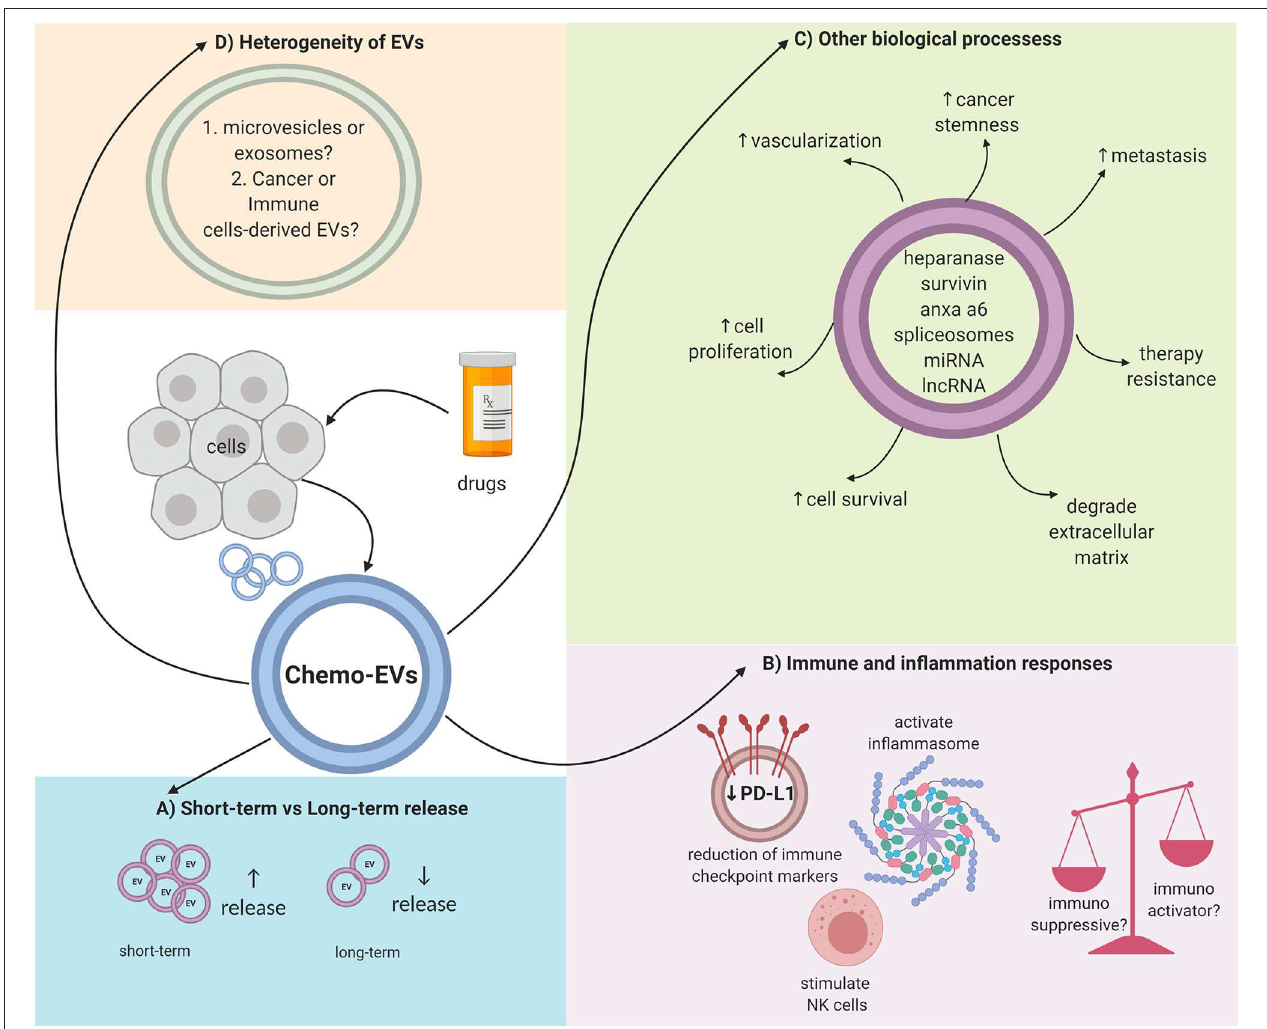
FIGURE 1 | Overall schematic representation on the complex properties of chemo-EVs. (A) The number of released EVs could be dependent on the duration of drug stimulation. (B) Immunomodulating effects of chemo-EVs (e.g., reduced immune checkpoint markers such as PDL-1, activated inflammasome, and stimulate natural killer cells). Nevertheless, the uncertainty between the immunosuppressive and immunoactivator capabilities of chemo-EVs warrants further investigation. (C) Chemo-EVs affect other tumor biological processes such as cell proliferation and cell viability through the different cargoes that it carries. (D) The heterogeneity